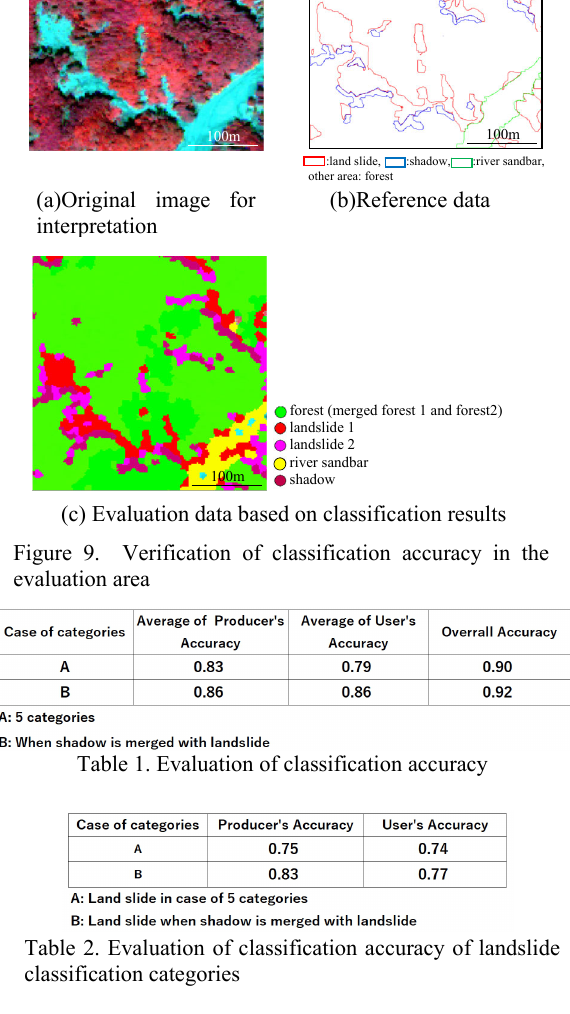
(b)Reference data (a)Original image for